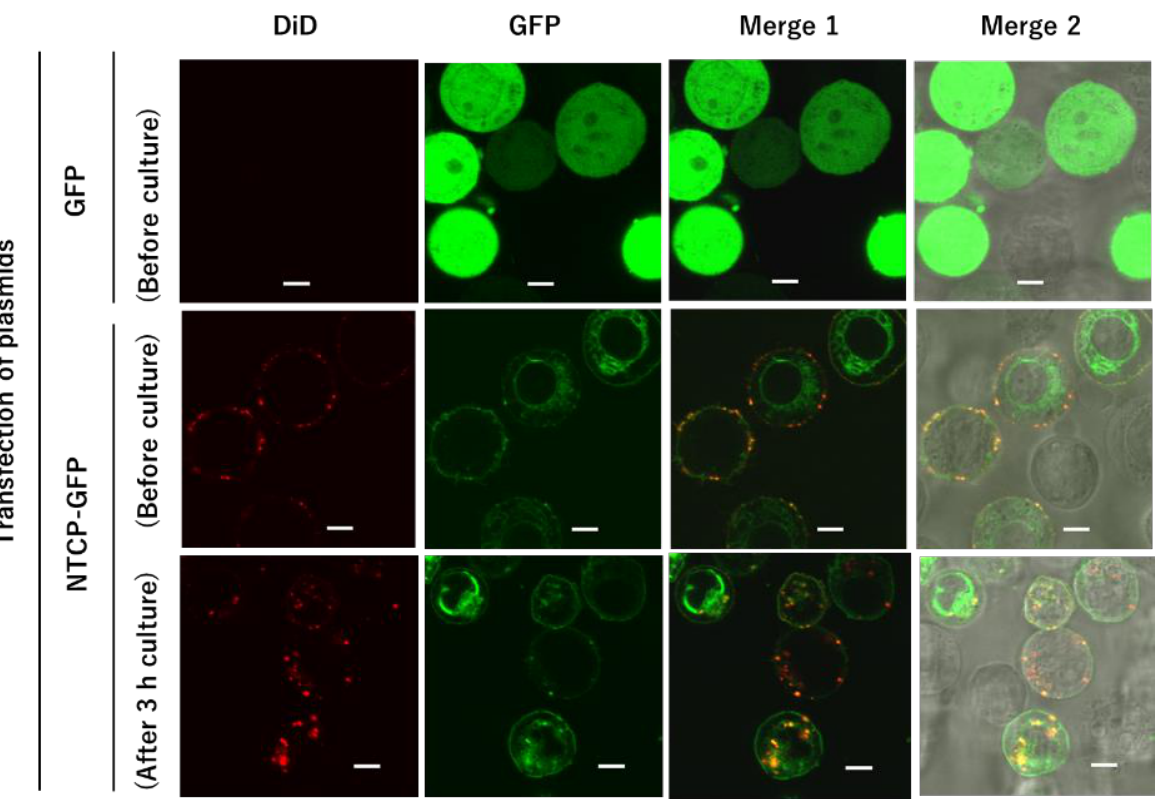
Figure 8. Cellular distribution of DiD-DOPC/PEG-Bio (10%) in HEK293T cells expressing GFP or NTCP-GFP after treatment with Myr47-Bio+SA followed by DiD-DOPC/PEG-Bio (10%). HEK293T cells transfected with GFP or NTCP-GFP expression plasmid were serially treated with Myr47-Bio+SA and DiD-DOPC/PEG-Bio (10%) on ice. These cells were washed with PBS and then a part of them was subjected to LSM as samples before culture (the upper and middle rows). The remaining cells were cultured in the culture medium at 37 °C, 5% CO 2 , for 3 h. After being washed with PBS, they were subjected to LSM (the lower row). DiD and GFP fluorescence detected under LSM are shown in red and green in the images, respectively. Merge 1: DiD and GFP images were merged and overlapping DiD and GFP fluorescence appeared to be yellow; Merge 2: Merge 1 and bright field images were overlaid; bars in the images indicate 5 μm.